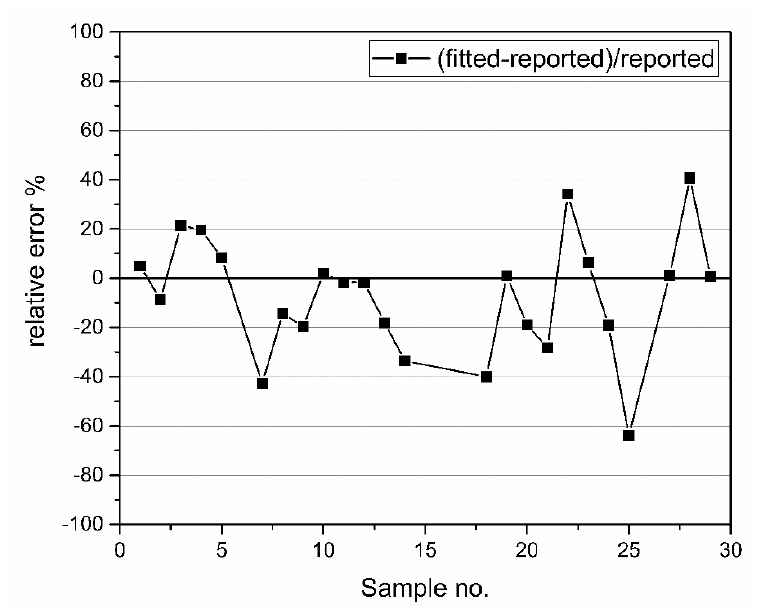
Figure 16. Comparison between relative error of fitted to reported concentration for the set of samples given in Table S3.